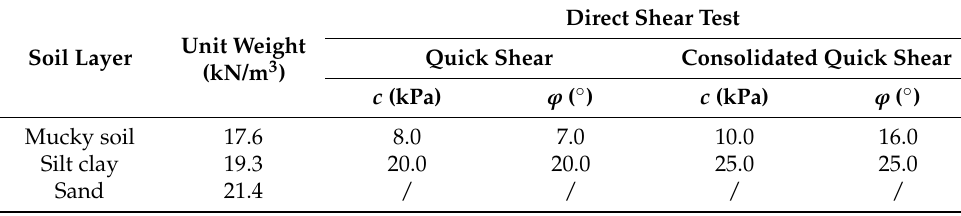
Figure 12. Longitudinal layout of the HZMB immersed tunnel (redrawn according to Lin et al. [41]). Table 5. Mechanical properties of soil layers under the HZMB immersed tunnel (data extracted from Hu et al.